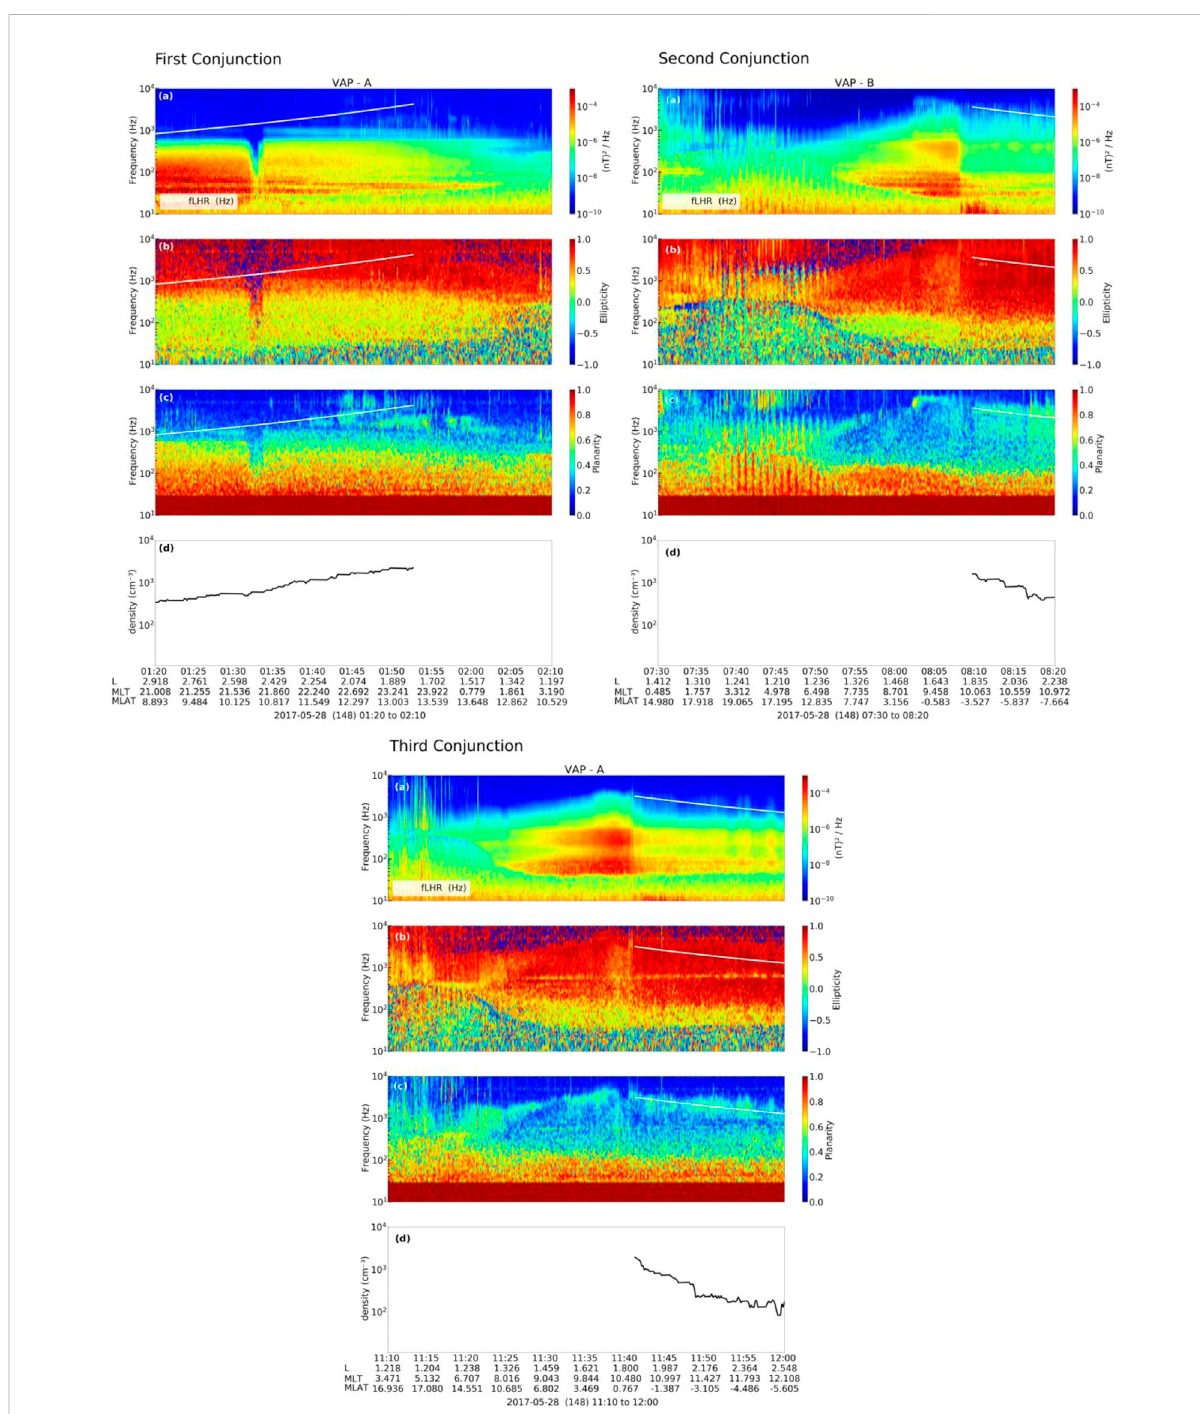
FIGURE 5 (A) The frequency-time spectrogram of the magnetic fi eld; (B) ellipticity; (C) planarity and (D) the total electron density during the fi rst (left panels), second (right panels) and third (bottom panels) conjunctions. The lower hybrid resonance frequency ( fLHR ) (white line) are presented in panels (A – C) . The ellipticity and planarity are calculated through the singular value decomposition method (Santolík et al., 2003). The fLHR and frequency-time spectrogram of magnetic fi eld are obtained from EMFISIS instrument and the electron density is inferred from the data of EFW instrument. The EFW and EMFISIS instruments are onboard the